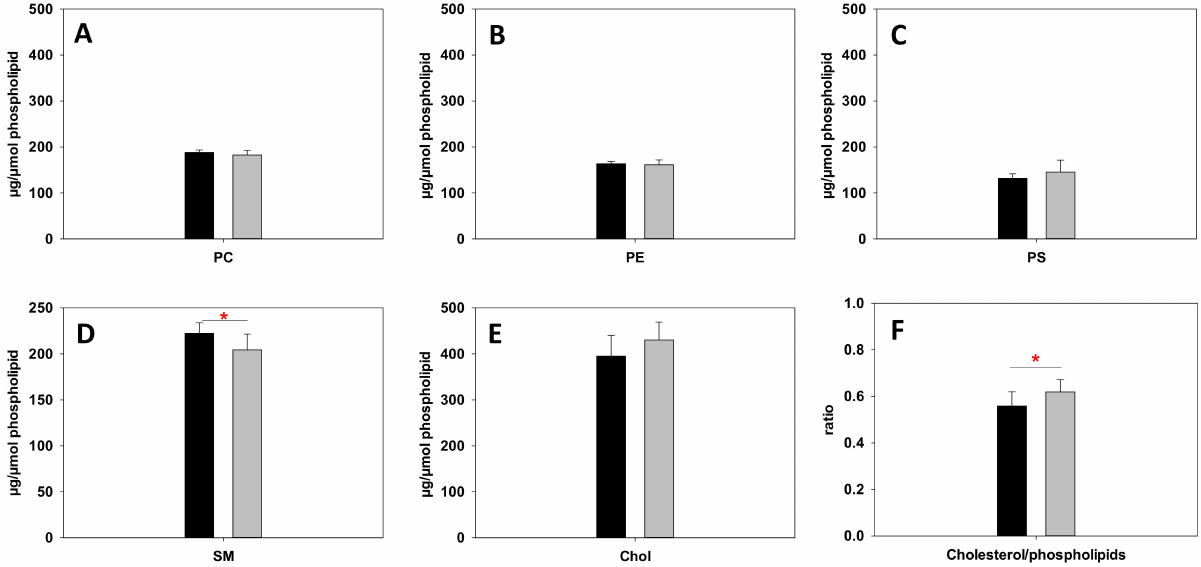
Figure 5. Lipidomic quantitation of specific lipid species in RBC. Species studied were PC ( A ), PE ( B ), PS ( C ), SM ( D ), and Chol ( E ). Chol/total phospholipid mol ratio is shown in panel ( F ). Black bars refer to control RBC group, while gray bars represent the obese patient RBC group. A significant decrease in SM and an increase in Chol/phospholipid ratio were detected for obese patient RBC. Average values ± S.D. Significance according to Student’s t-test: (*) p < 0.05. n =